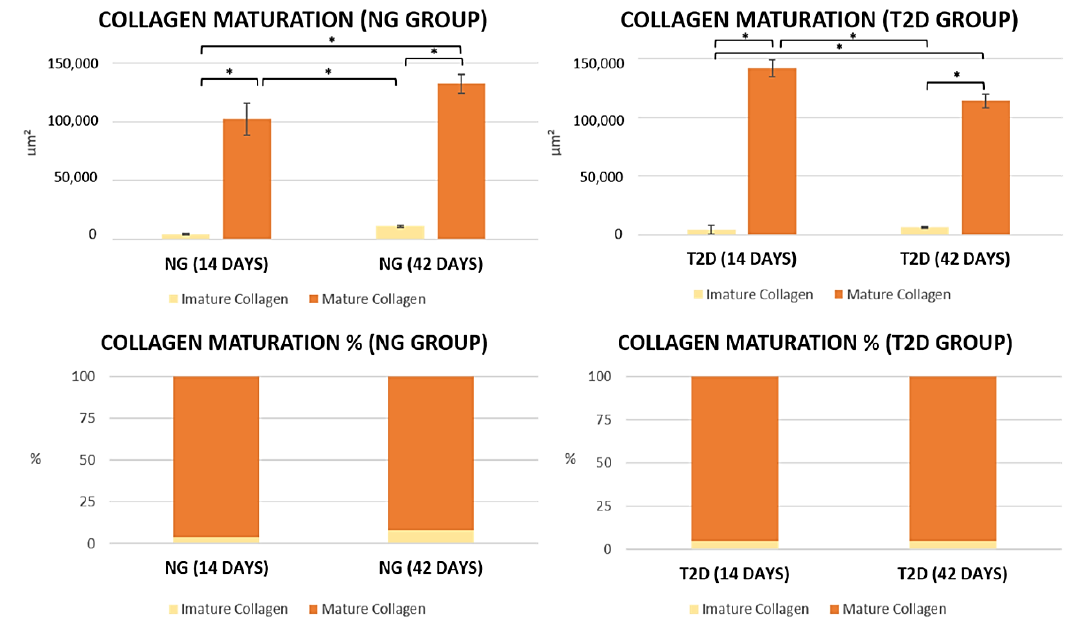
Figure 6. NG and T2D collagen fibers maturation. Graphs showing collagen maturation between the groups. It is possible to observe that the T2D group has a decrease in mature collagen fibers over the days, while the NG group has an increase in mature collagen fibers. Symbols: Error bar; * p < 0.05.